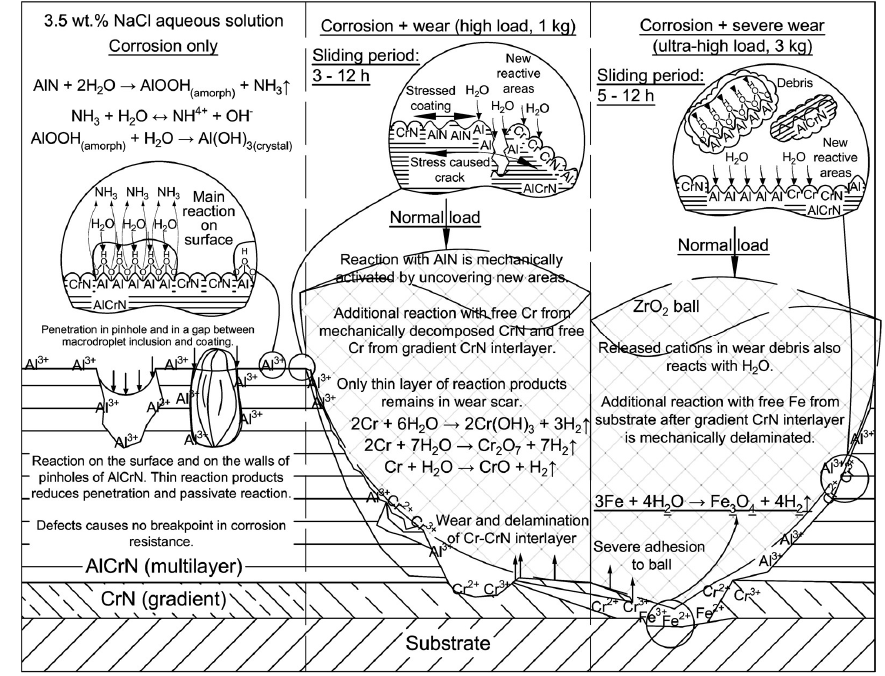
Figure 8. Simplified schematic illustration indicates main processes on the surface and in the wear scar during static corrosion and 12 h tribo-corrosion tests. A period when damage of interlayer or substrate took place in case of 1 or 3 kg tests, respectively is indicated. A ball is shown only for illustration without scaling. Mainly released cations are indicated.